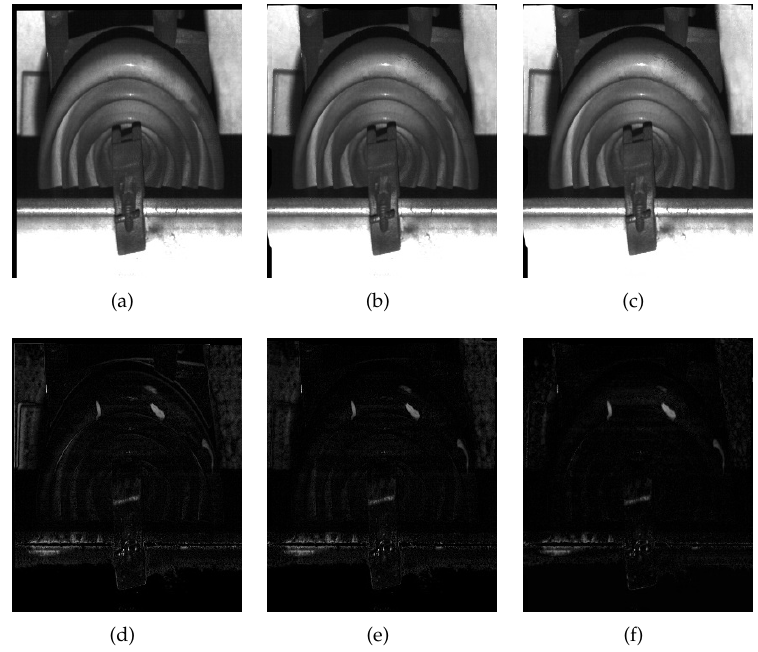
( x , y ) using feature matching i , j